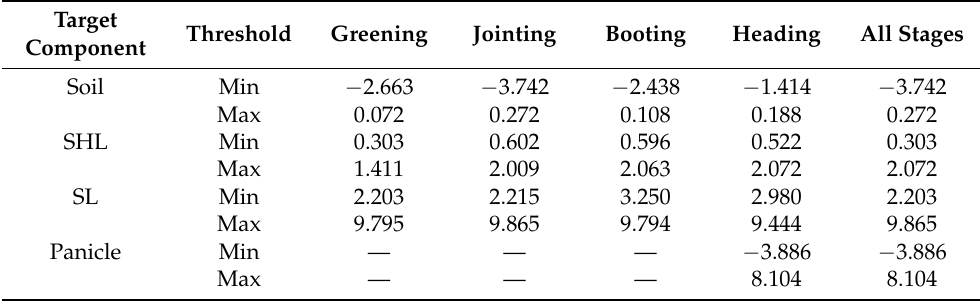
Figure 4. Histogram-based statistical analysis of target components at the ( a ) greening, ( b ) jointing, ( c ) booting, and ( d ) heading stages based on the spectral classification index (SCI). Table 3. The maximum and minimum SCI values of the target components at different stages. The values in the last column (all stages) are the corresponding minimum or maximum values in a